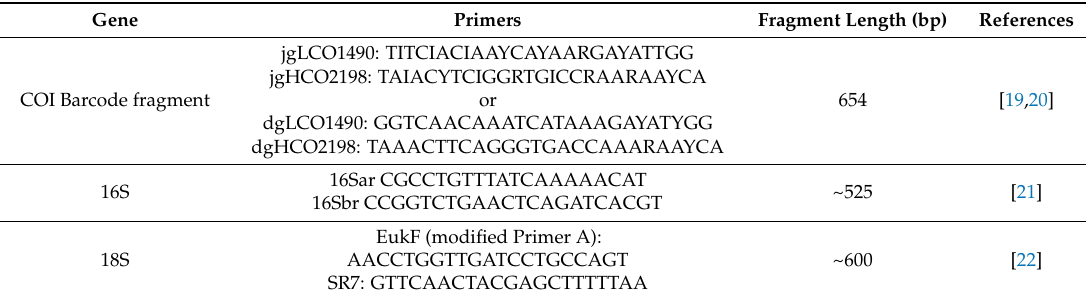
Table 1. Summary of primers and DNA fragments used in this